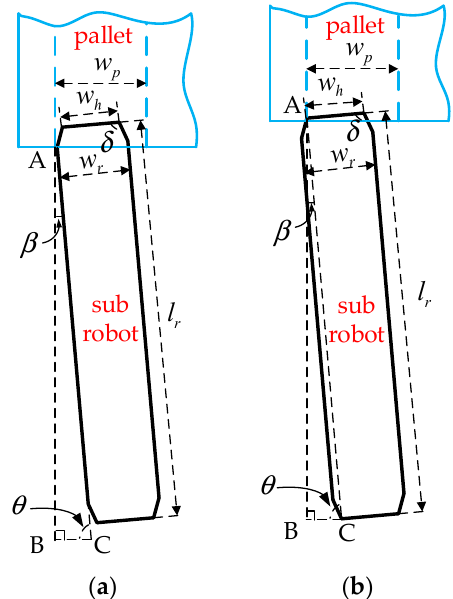
Figure 9. The maximum deviation angle error of a sub robot docking to the free entry of the pallet. ( a ) The ideal case; ( b ) The extreme